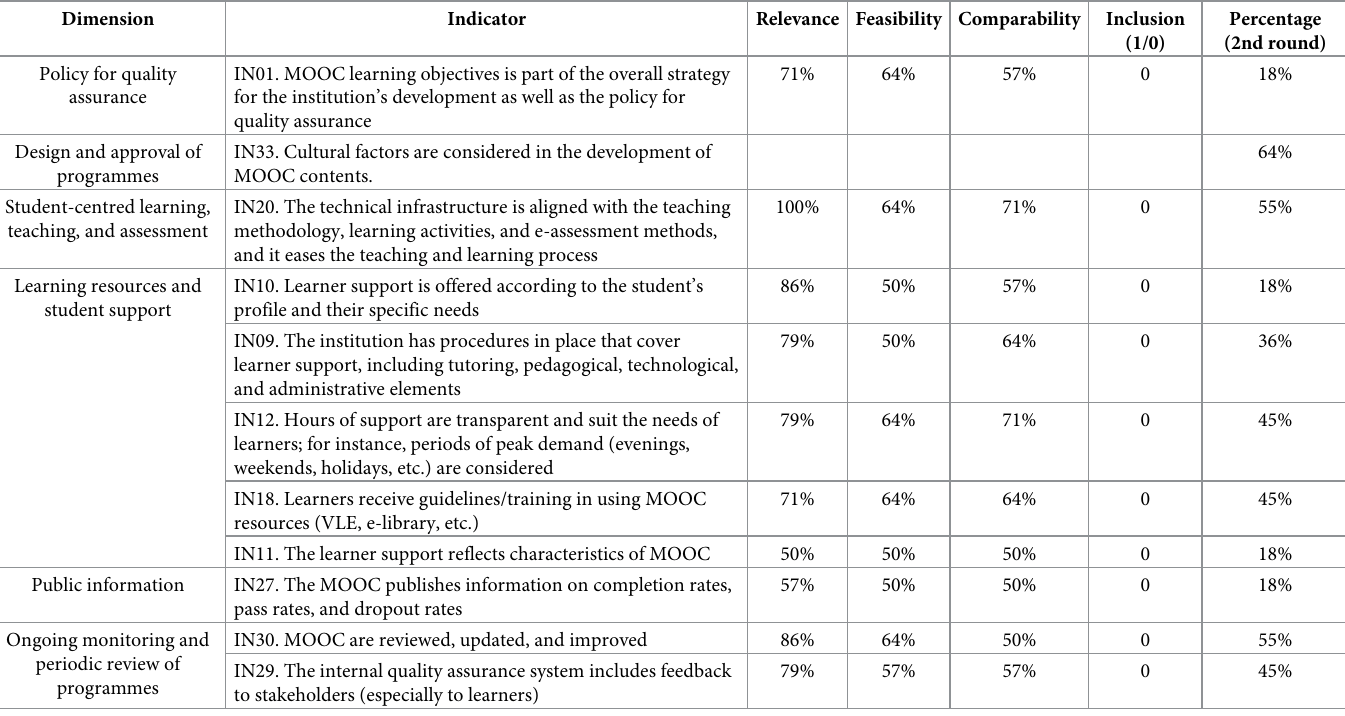
Table 4. Indicators results of the Delphi process to NOT be included.